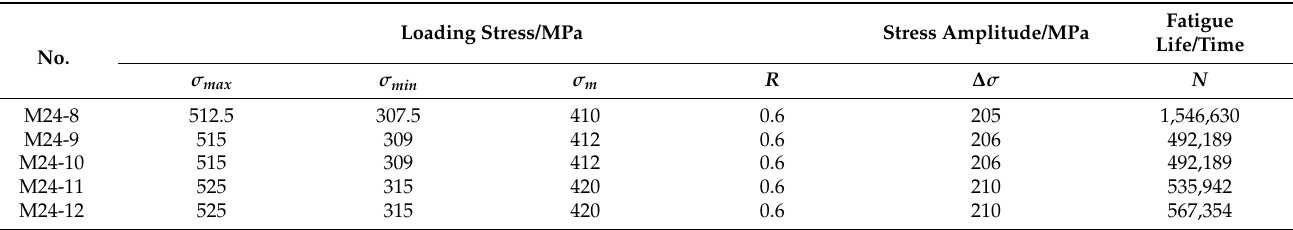
Table 6. Constant amplitude fatigue test results of M24 torsional shear-type high-strength bolt with pretension ( σ max = 512.5–525